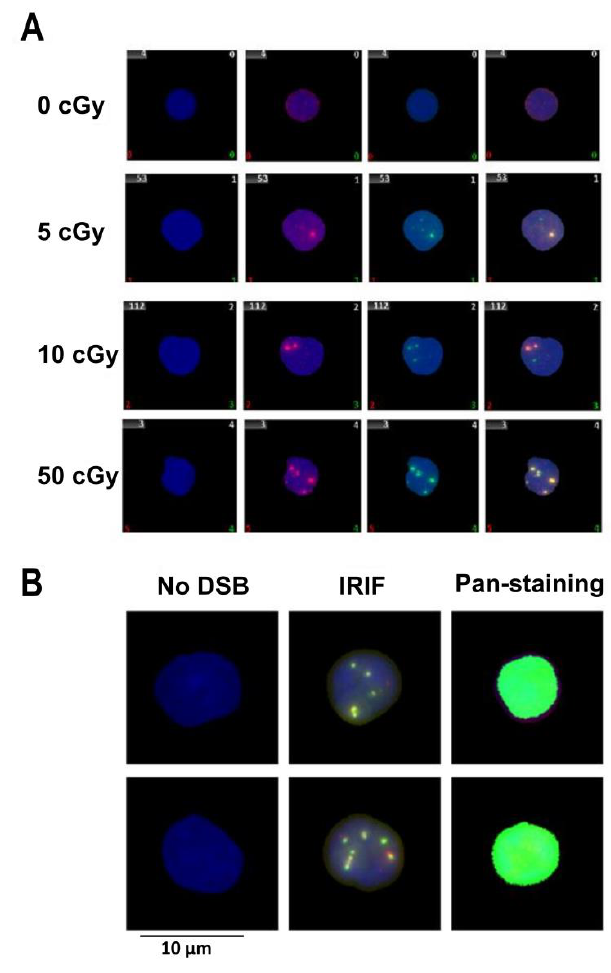
Figure 1. Representative images of nuclei from human UCB. Representative images of: ( A ) the nuclei (stained with DAPI in blue) from the human cord blood lymphocytes 30 min post-irradiation with 0 (sham irradiated control), 5, 10, and 50 cGy: γ H2AX foci (green), 53BP1 (red), co-localized γ H2AX / 53BP1 overlay of green and red (yellow); and ( B ) representative raw images of pan-nuclear staining of γ H2AX observed in human cord blood lymphocytes 22 h post-irradiation by the dose of 50 cGy.